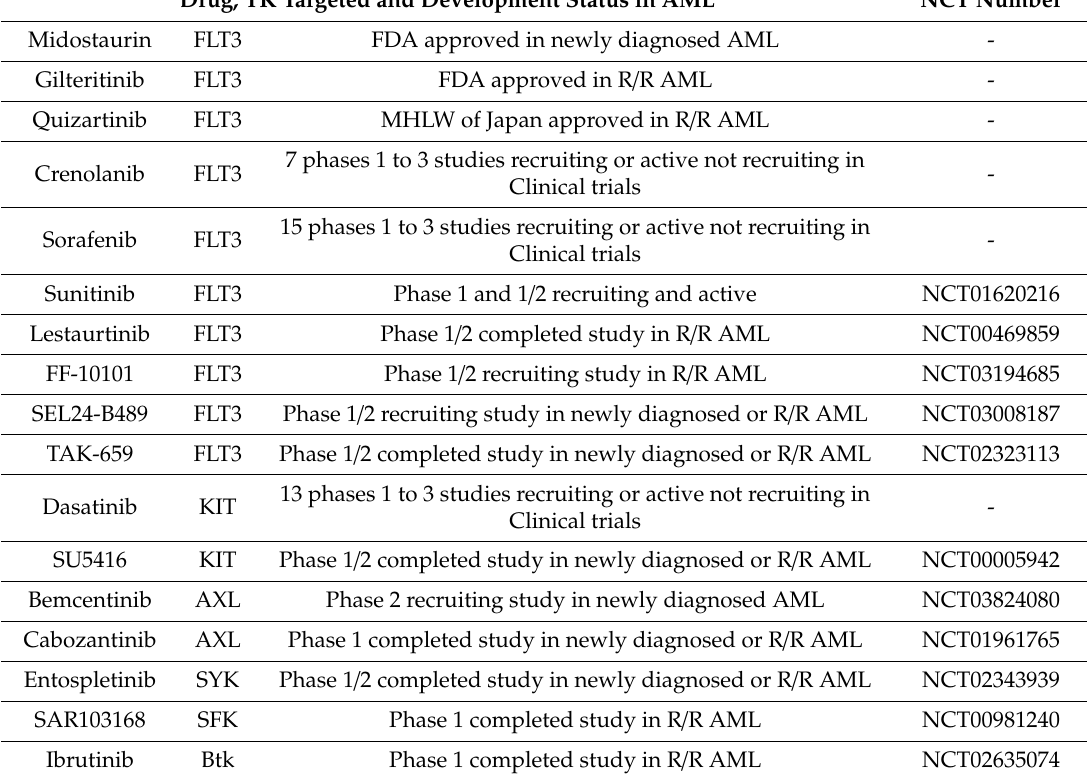
Table 1. TKI-based clinical trials in acute myeloid leukemia (recruiting, active, not recruiting or completed